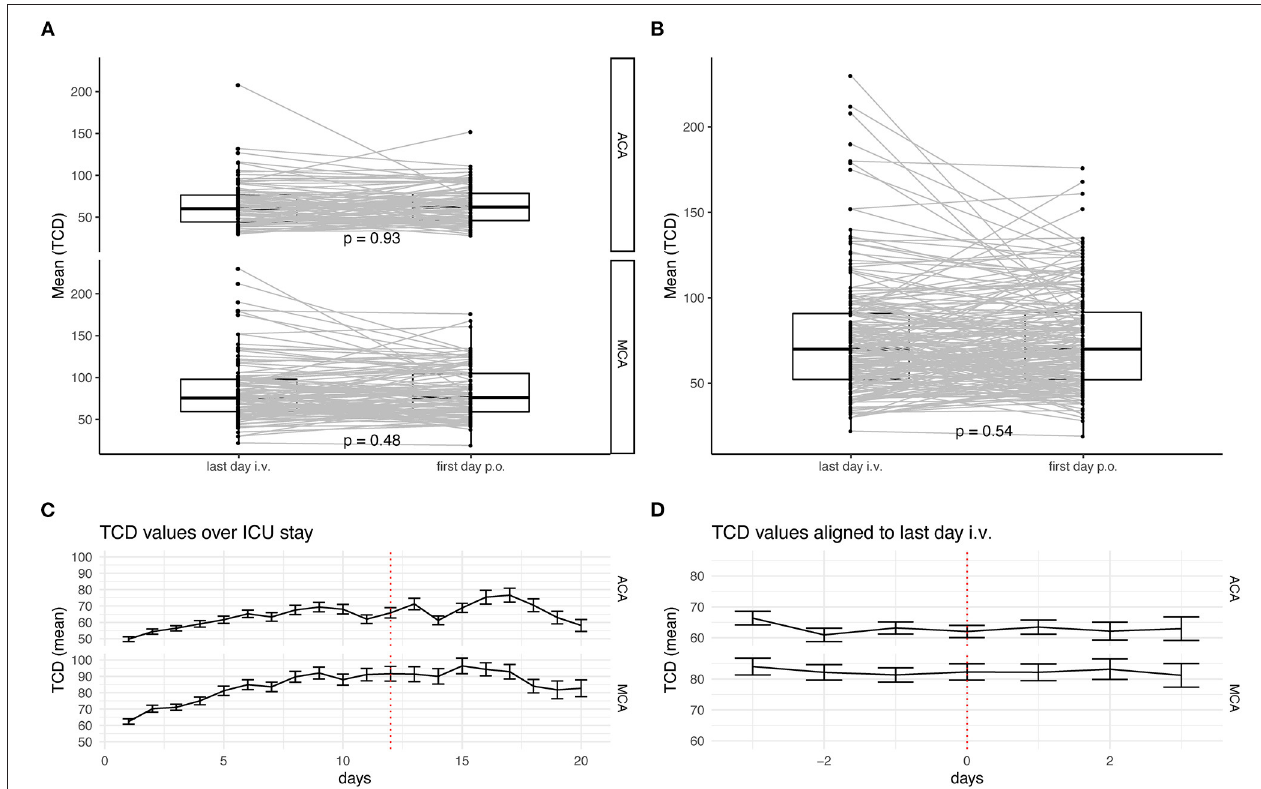
FIGURE 1 | Analysis of TCD-values during the switch of the route of administration. (A) TCD values are measured longitudinal in patients. Only patients with consecutive values before and after switching the route of administration of nimodipine are depicted. Values for A. cerebri anterior (upper) and A. cerebri media (lower) are depicted separately. (B) All TCD values independent of their circulation are depicted. The lower and upper hinges of the boxplots correspond to the first and third quartile of all values. The whiskers represent the 1.5 inter quantile range (IQR). Dots show each value and grey lines connect individual patients’ measurements. Statistical analysis was performed with paired t -test. (C) Mean TCD values are shown over the first 20 days of ICU stay for A. cerebri anterior (upper) and A. cerebri media (lower). Error bars represent the standard deviation. (D) Mean TCD values aligned to the individual switch of the route of administration. Whiskers represent. Error bars represent the standard